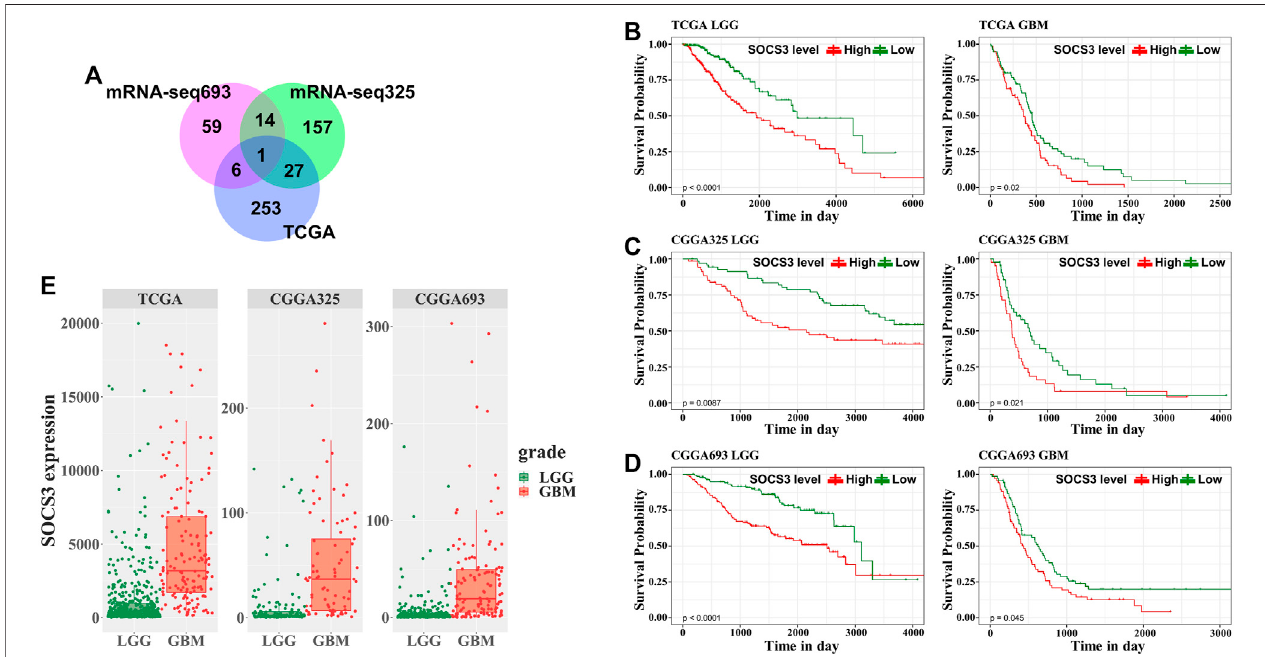
FIGURE3| UnivariatesurvivalanalysisinGBMandLGGstrati fi edbySOCS3expressionbasedontheTCGAandCGGAdata. (A) AmongcommonDEGs,SOCS3 was identi fi ed as the signi fi cant gene by univariate Cox regression. Kaplan-Meier estimates of glioma patient survival according to SOCS3 gene expression from (B) TCGA, (C) CGGA325, (D) and CGGA693. (E) Comparison of SOCS3 gene expression between the GBM and LGG cohorts from TCGA, CGGA325 and